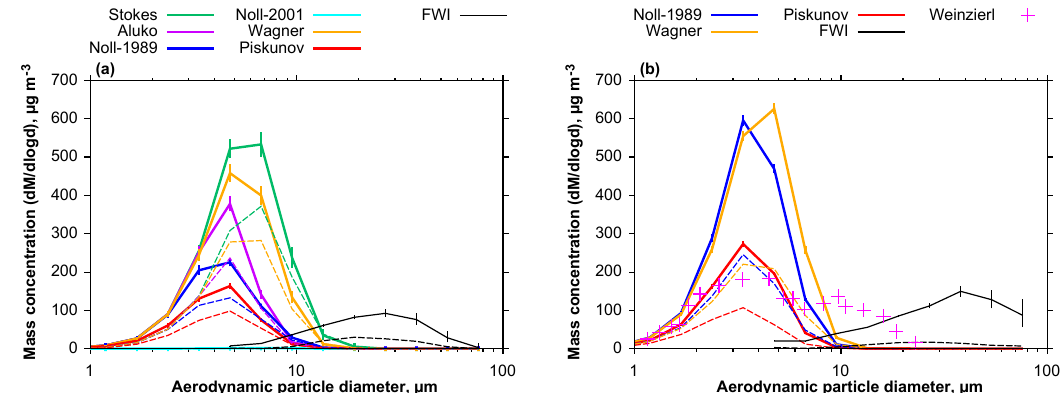
Figure 9. Average atmospheric mass size distribution densities derived from DPDS and FWI measurements. (a) The period from 10 to 15 July 2013; (b) and the period from 14 June to 8 July 2013. Different colors refer to different deposition velocity estimates as shown in Fig. 4. Solid lines refer to total mass concentrations, dashed ones to the dust mass estimated from the chemical composition (upper limit estimate). Error bars show the central 95% confidence interval. Pink crosses show a size distribution measured in the Saharan Air Layer on 22 June 2013 (Weinzierl et al., 2017). Note that for particles smaller than 10µm the FWI data may contain a considerable bias in